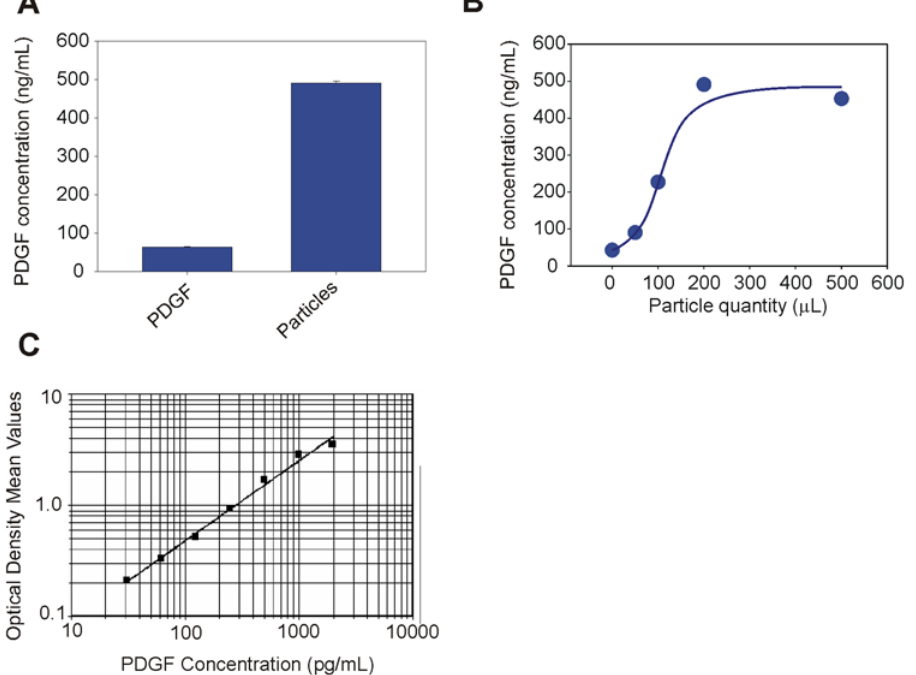
Figure 6. Core shell particles increase the concentration of extremely dilute PDGF approximately 10-folds (1000 percent) as measured by ELISA assay. (A) ELISA readings of the starting solution of PDGF in Calibrator diluent RD6-3 (R&D Systems, animal serum with preservatives) at a concentration of 63.69 + / 2 1.448 pg/mL and PDGF eluted from core-shell particles (491.14 + / 2 4.818 pg/mL). (B) PDGF concentration in core-shell particle eluate plotted against the quantity of particles utilized for the incubation, duplicate experiments. (C) ELISA standard curve of PDGF concentration versus absorbance. The standard curve was generated with two repeats for each PDGF calibrator concentration.